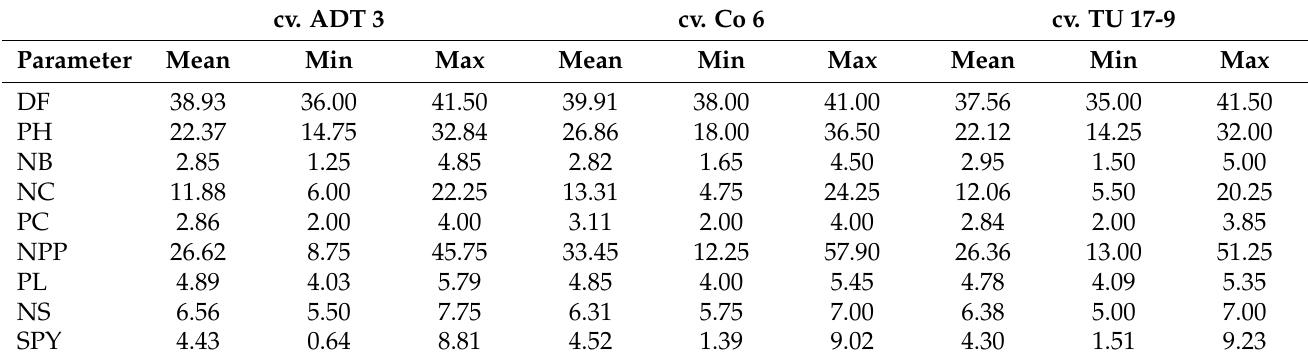
accounted for 46.85, 19.10, and 10.08% of the variation and were largely contributed to The eigenvalues for PC1, PC2, and PC3 were 3.57, 1.71, and 1.14 for cv. ADT 3; 3.59, 1.64, and 1.22 for cv. Co 6; and 4.22, 1.72, and 0.91 for cv. TU 17-9, respectively. The mutant populations of each blackgram cultivar formed three clusters; for cv. ADT 3, cluster I consisted of 8 genotypes, cluster II formed a larger size with 37 genotypes, and cluster III comprised 15 genotypes. Similarly, for cv. Co 6, clusters I, II, and III comprised 20, 3 and 16 genotypes, respectively. For cv. TU 17-9, clusters I, II, and III comprised 8, 17, and 3 genotypes, respectively (Figure 4). The selection was imposed on M 4 mutants, and 36 uniform, nonsegregating mutant progenies showing desired yield-related traits were selected to raise the M 5 population. Table 1. Mean and range for nine yield-related traits of M 4 mutant populations of three blackgram cultivars. cv. ADT 3